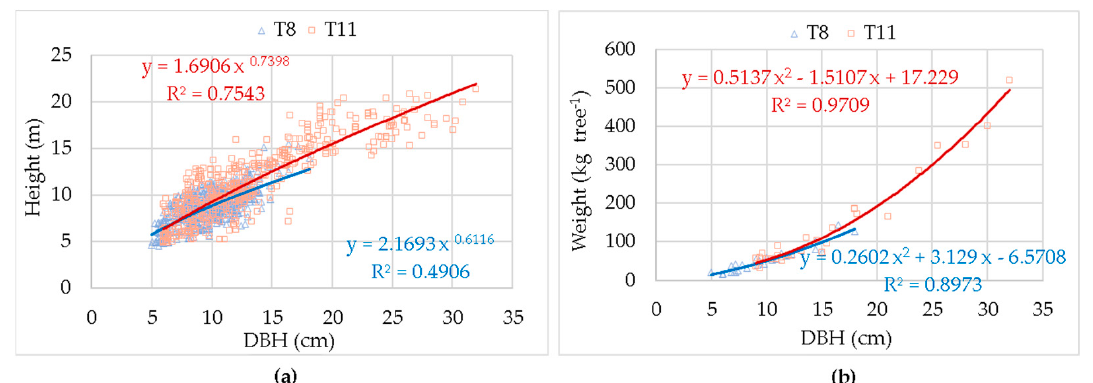
Figure 3. Relationship between height and diameter at breast height (DBH) in T8 (616 obs.) and T11 (460 obs.) plantations ( a ), and weight equations as a function of the DBH (30 obs. for each section) ( b ).